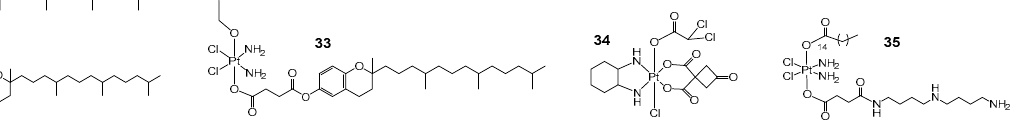
Figure 6. Multi-targeting structure modification to actualize diverse antitumor actions. ( 32 , 33 ) Pt(IV) complexes of vitamin E and a-TOS. ( 34 ) Structure of compound designed by Su’s group. ( 35 ) Polyamine-Pt(IV) prodrug. Reprinted with permission from Ref. [67,68,72].